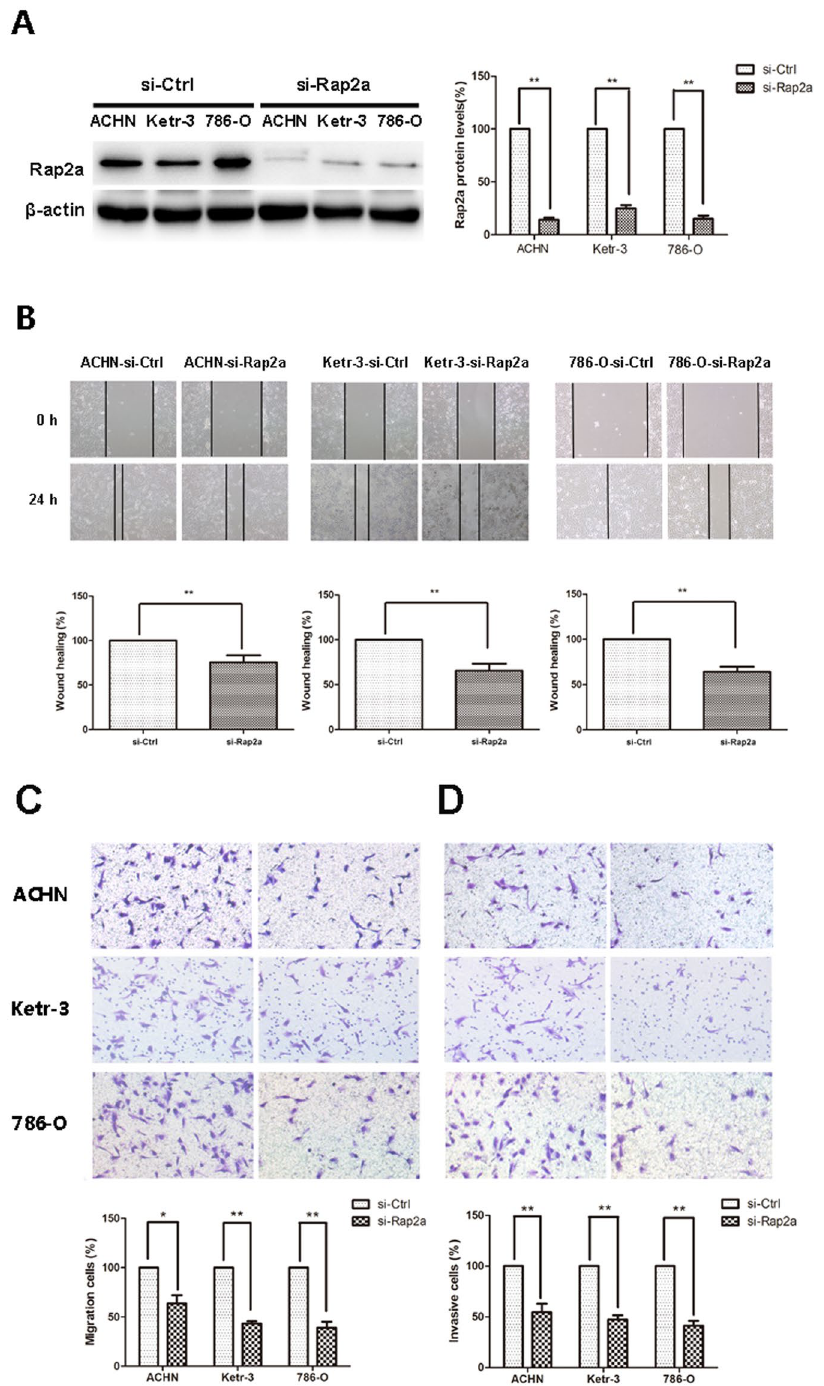
Figure 3. Effects of Rap2a knockdown on invasion and migration in RCC cells. ( A ) Western blot analysis of Rap2a knockdown in Ketr-3, 786-O, and ACHN group with Rap2a antibody. β -actin served as loading control. ( B ) Effects of Rap2a knockdown on the migration ability of RCC cells were examined by wound-healing assay. ( C , D ) Cell migration was measured by using a migration assay following the transfection of ACHN, Ketr-3 and 786-O cells with Rap2a siRNA. Invasion assays were performed by using a similar procedure. Data are presented as mean ± SD (n = 3). * P < 0.05, ** P <